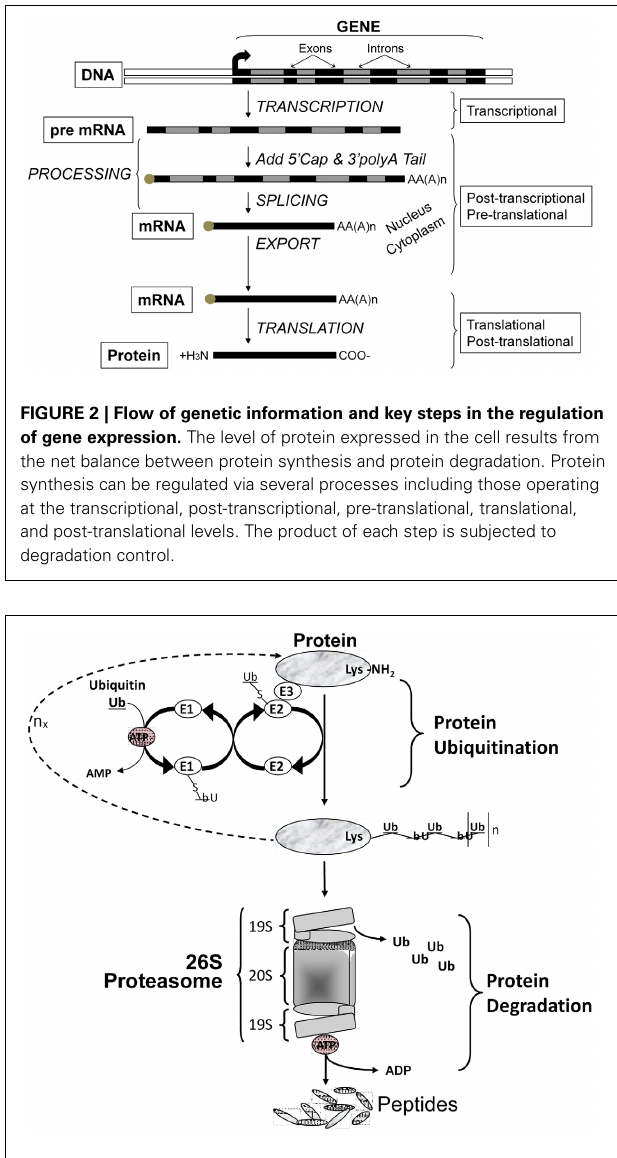
FIGURE 3 | Protein degradation via the ubiquitin/proteasome system. Multiple Ub molecules are covalently conjugated to amino groups of the protein. Ub is first activated by E1 (Ub activating enzyme), then transferred to E2 (Ub carrier protein or Ub-conjugating enzyme) to be ligated to an amino group of the target protein with the help of E3 (Ub-protein ligase). This is followed by a sequential conjugation of additional Ub molecules each linked to an NH2 group of a lysine of the previously added Ub, thereby generating a polyubiquitinated protein that becomes recognized by the 26S proteasome machinery and targeted for